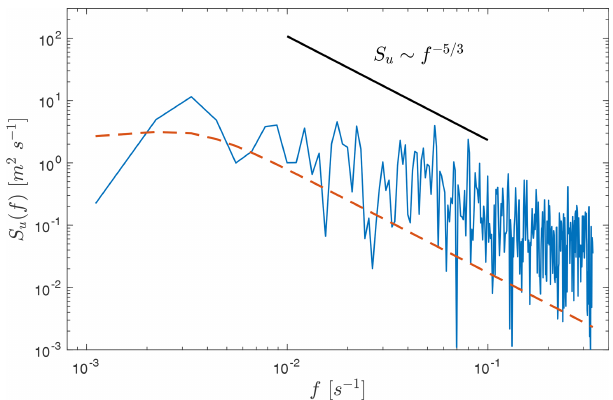
Figure 4. Example of model fit to experimental spectrum of the line-of-sight velocity measured by the Halo Streamline lidar at 105m above the surface on 15 July at 01:23UTC. Turbulence dis- sipation at this time was 118 × 10 − 2 m 2 s − 3 . The red dashed line shows the spectrum fit. The solid black line shows the theoretical − 5 / 3 slope of the spectrum in the inertial